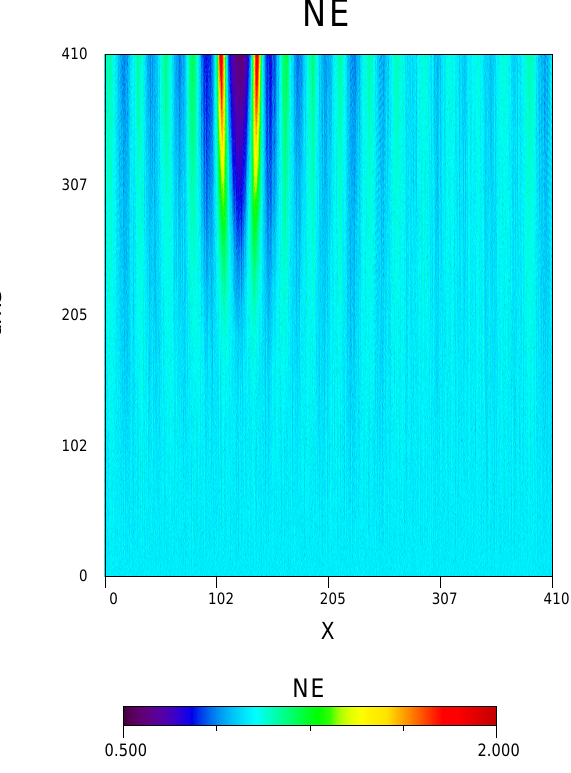
Fig. 10. AWC001. Temporal stack plot of the electron density n e (X,t) . including the setting of a non-propagative structured longitu- dinal field E X